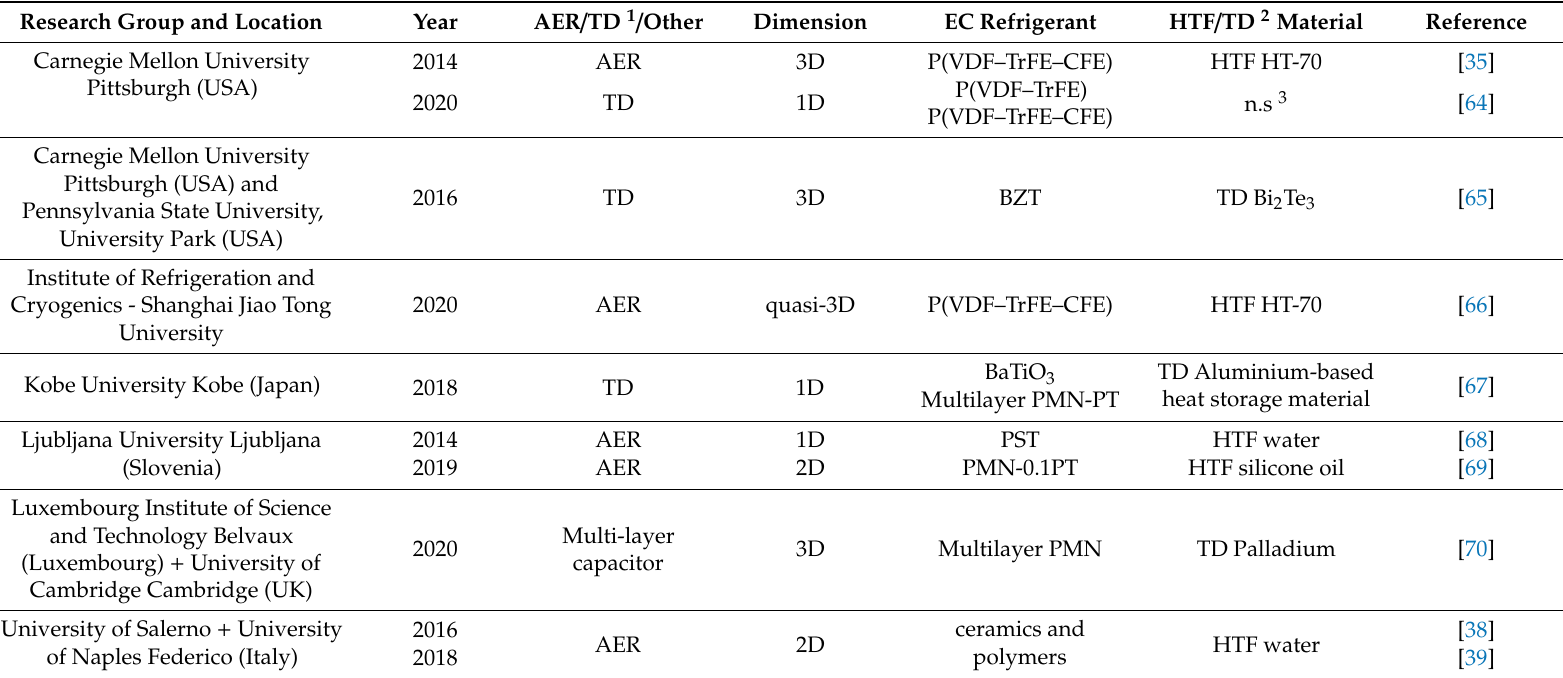
Table 4. Numerical models of electrocaloric devices introduced in the literature up to